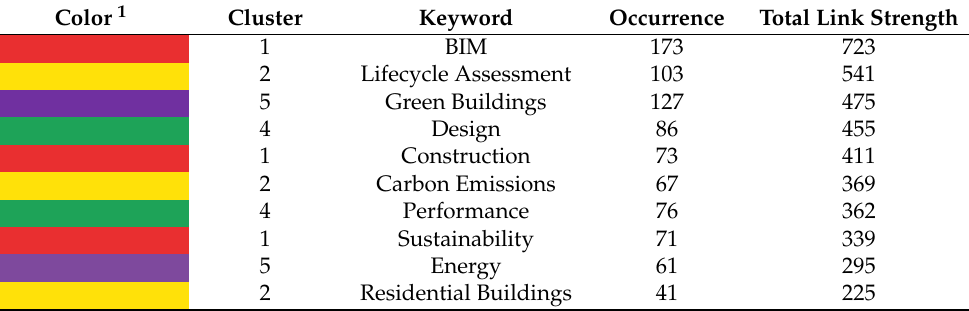
Table 1. High-frequency keywords of published articles regarding BIM in the field of carbon emissions for sustainable buildings from 2008 to 2021 (14 years) via the network visualization of VOSviewer software (generated by the authors).